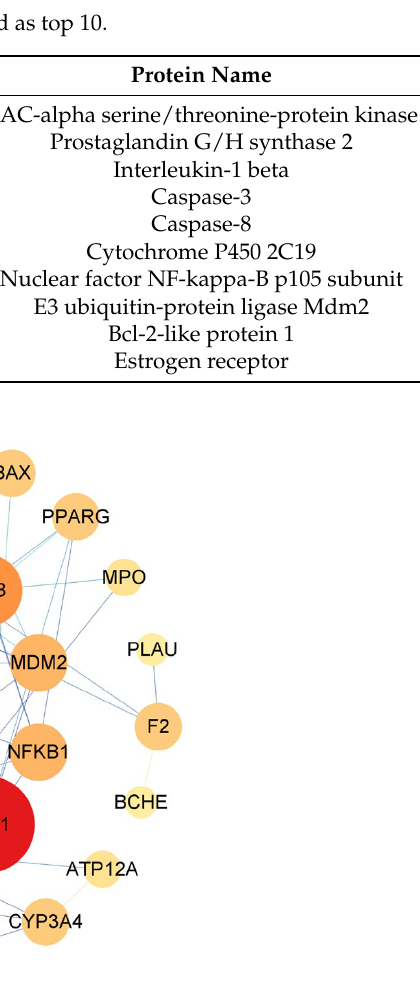
Table 3. The potential hub proteins ranked as top 10.